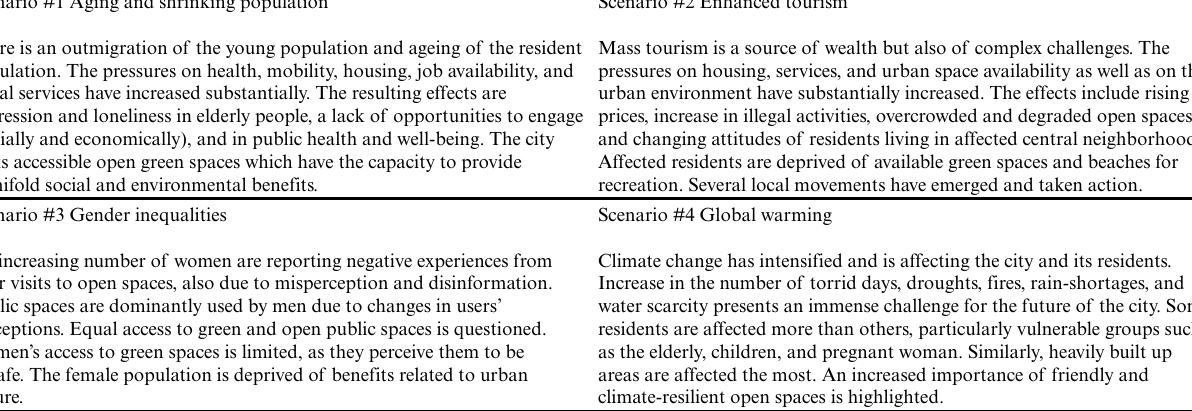
Table 2. Four scenario narratives co-developed with the Urban Resilience Department. Each scenario is centered around a single narrative that represents a major challenge for urban